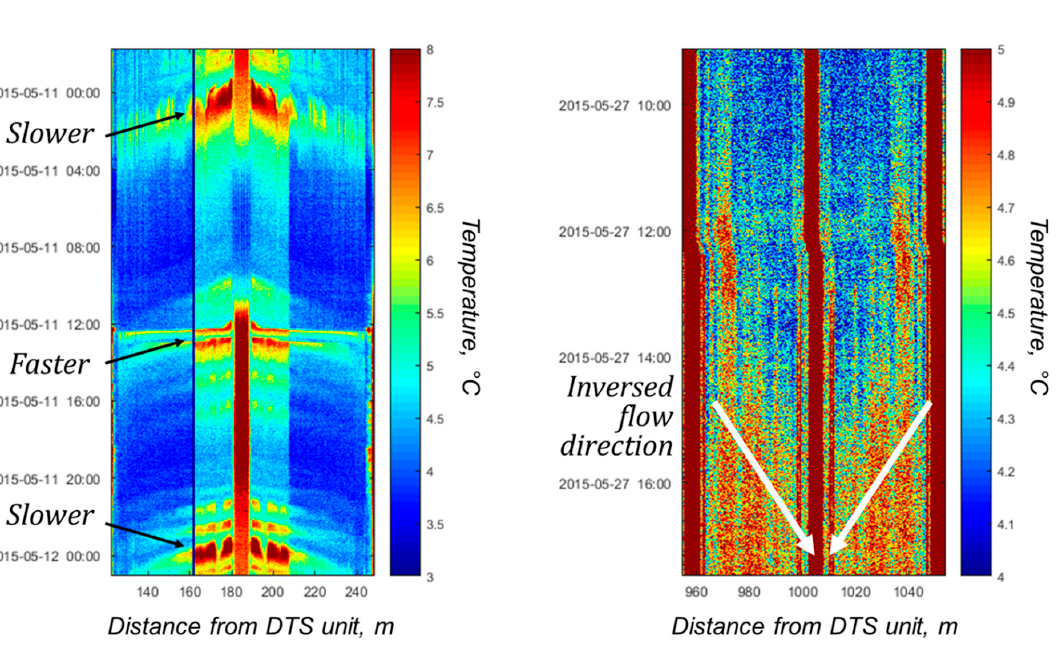
Figure 5. Additional information obtained from DTS plots: relative flow speed in loop L3 ( left ) and flow direction in loop L5 ( right ). Note different temperature scales.